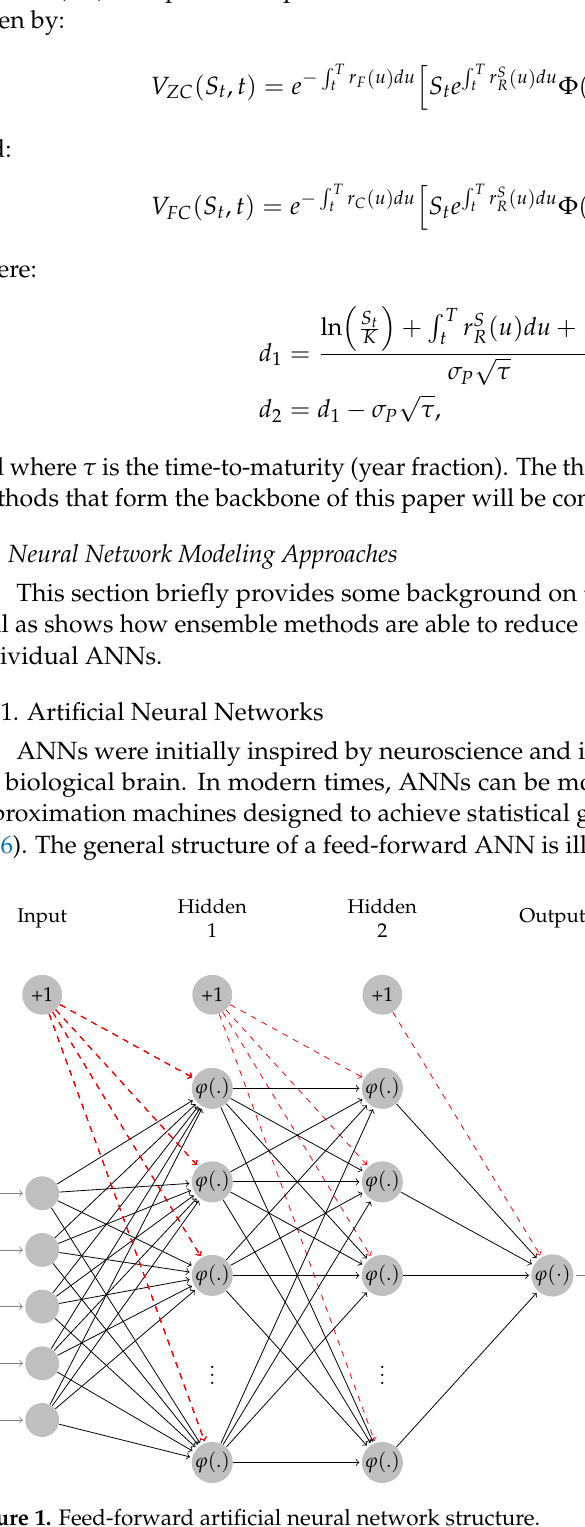
Figure 1. Feed-forward artificial neural network